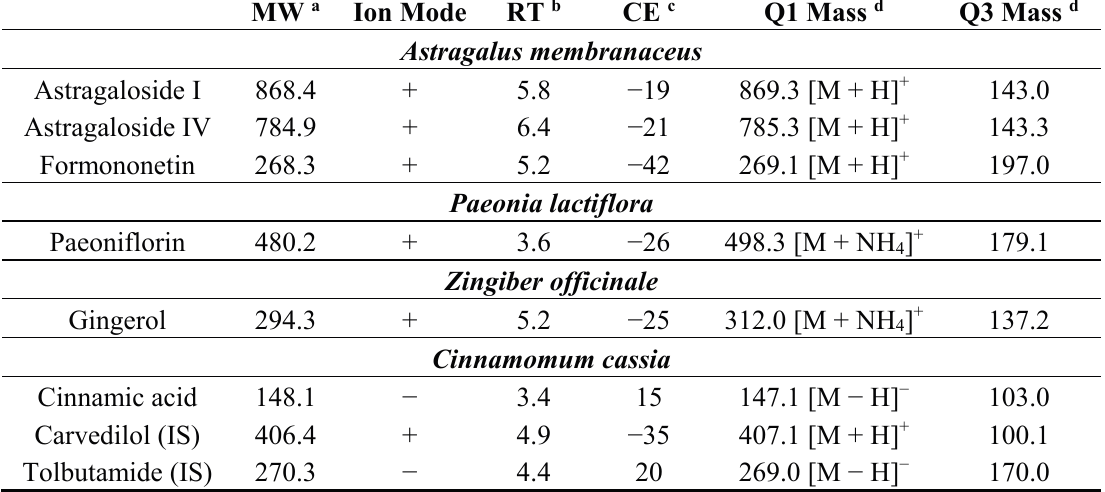
Table 1. The LC-MS/MS conditions for the identification of the six active components and two internal